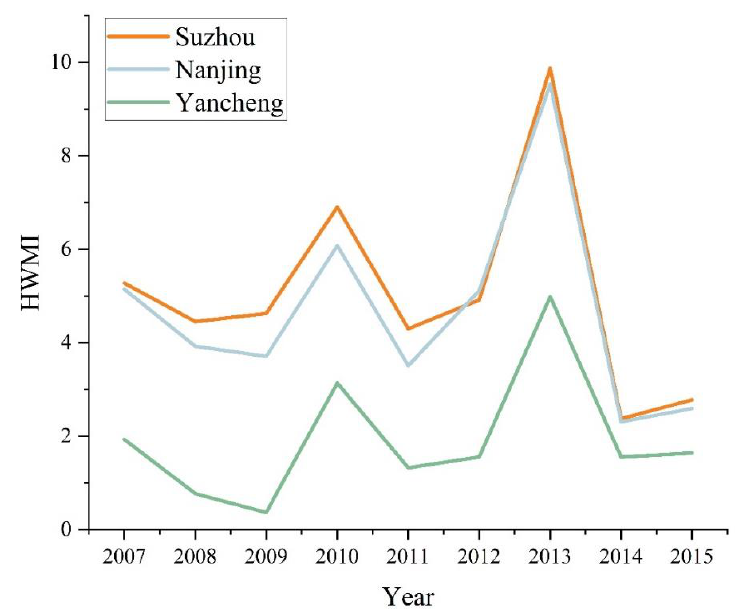
Figure 4. HWMI from 2007 to 2015.